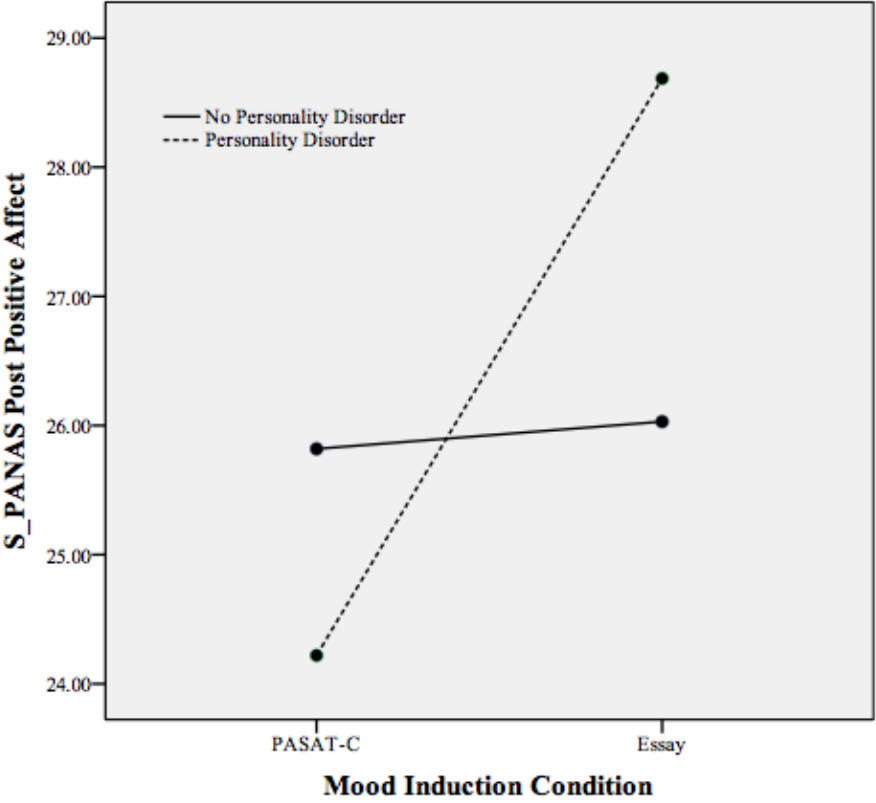
Figure 5. Plot of the statistically significant interaction between mood induction condition and personality disorder on the PANAS positive affect scale following both mood inductions. Higher scores indicate greater positive